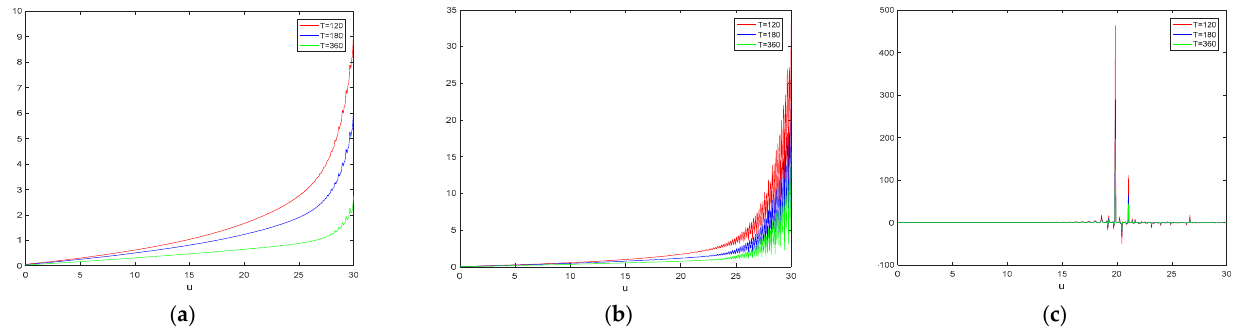
Figure 5. Estimation of the ruin probability: mean relative error curves. ( a ) Exponential claim size density; ( b ) Erlang (2) claim size density; ( c ) Gamma (1.5,1.5) claim size density.